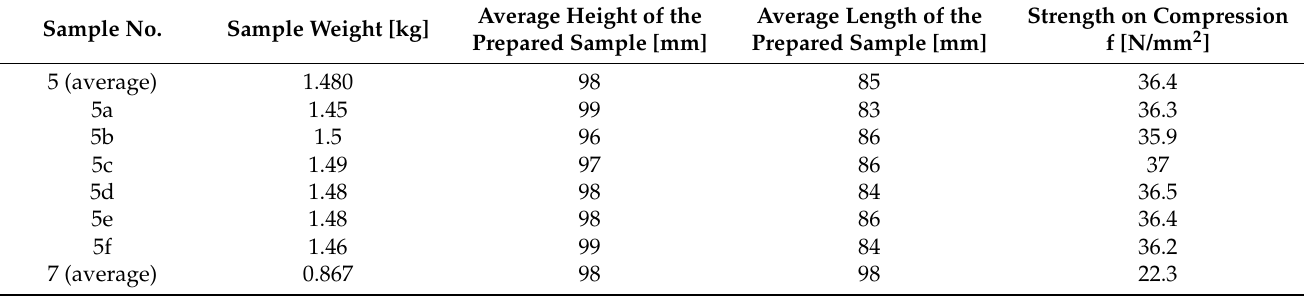
Table 2. Strength test results for samples no. 5a–f and